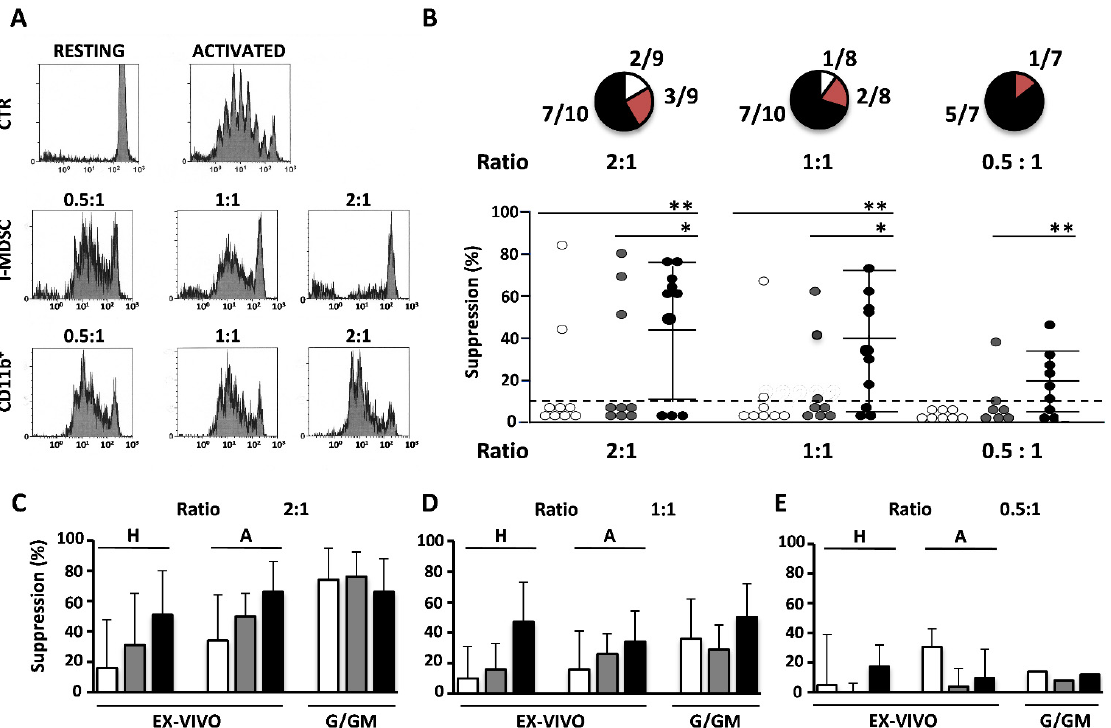
Figure 2. Ex vivo and inducible I-MDSC suppression observed during aging. ( A ). Representative sup- pression assay analyzed by flow cytometry. Plots refer to CD3-gated T lymphocytes non-stimulated (RESTING), activated in the absence (ACTIVATED) or in the presence of lymphocyte–monocyte- depleted CD33 + CD11b − CD16 − cells (I-MDSCs) or CD33 + CD11b + CD16 − (CD11b + ) cells at the indicated ratios. Mean value of T cell activation was 90 ± 8% SD. ( B ) (upper panel). Number of BM samples containing active I-MDSCs out of the indicated number of elders (black portion), adults (red portion), and young people (white portion). ( B ) (lower panel). Percentage of heterologous ex vivo suppression of I-MDSCs of young people (white dots), adults (grey dots), and elders (black dots) at the indicated ratio. Dot values are the mean of duplicates. Dotted line indicates the 10% of suppression arbitrarily considered negative. ( C – E ). Mean value ±SD of the percentages of heterolo- gous (H) and autologous (A) ex vivo suppression (EX VIVO) and of the heterologous G/GM-induced (G/GM) suppression of young people (white bars), adults (grey bars), and elders (black bars) at the indicated I-MDSC/PBMC ratio, respectively of 2:1 ( C ), 1:1 ( D ) and 0.5:1 ( E ). ; p -values as in Figure 1. * p < 0.05, ** p < 0.01.